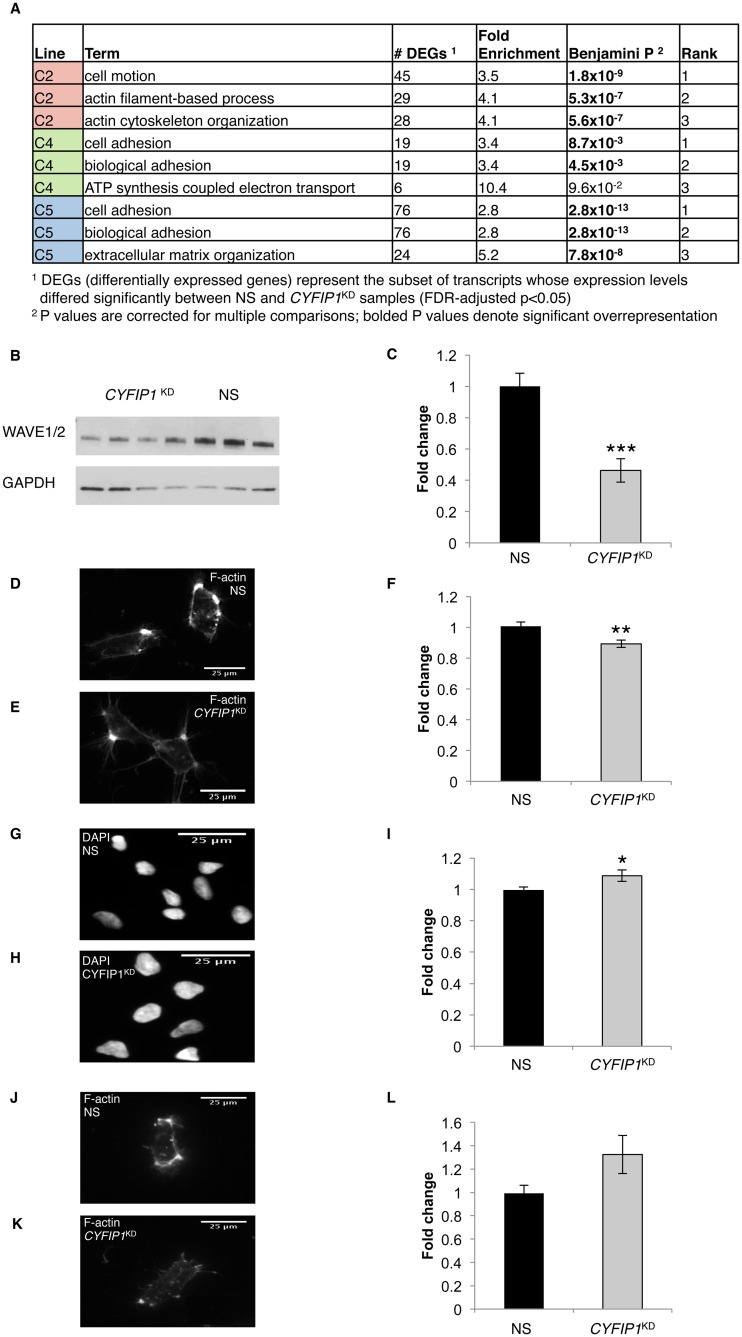
Dysregulation of cytoskeletal remodeling in response to CYFIP1 knockdown in human neural progenitor cells (NPCs).(A) Genes involved in cytoskeletal remodeling are overrepresented among transcripts downregulated in response to CYFIP1 knockdown. (B, C) Western blot shows that relative to non-silencing shRNA transduced NPCs (NS, black), transduction with an shRNA targeted against CYFIP1 (CYFIP1KD, grey) results in a significant 54% reduction of WAVE1/2 protein levels. n = 10 per group. (D, E, F) Phalloidin staining shows that F-actin levels are significantly reduced (11% reduction) in CYFIP1KD NPCs relative to control cells. n = 12 wells per group. (G, H, I) Nuclear area, quantified by DAPI, is significantly increased by 9% in CYFIP1KD NPCs relative to control cells. n = 12 wells per group. (J, K, L) Cell area, captured by phalloidin staining, is nominally greater in CYFIP1KD NPCs relative to control cells (34% increase). n = 12 wells per group. Two-tailed Student’s t-test, *p<0.05 **p≤0.01 ***p≤0.001.